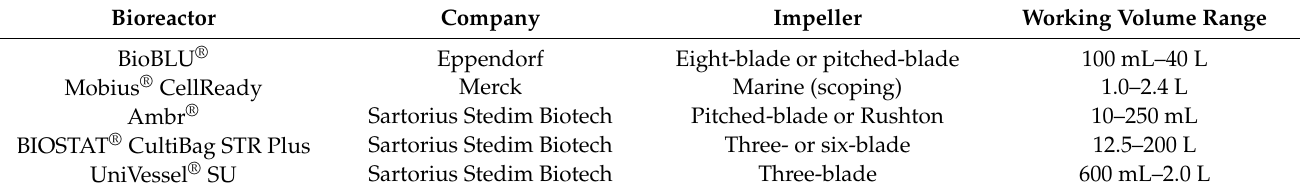
Table 2. Examples of single-use stirred-tank bioreactor systems with successful use for stem cell culture. Bioreactor